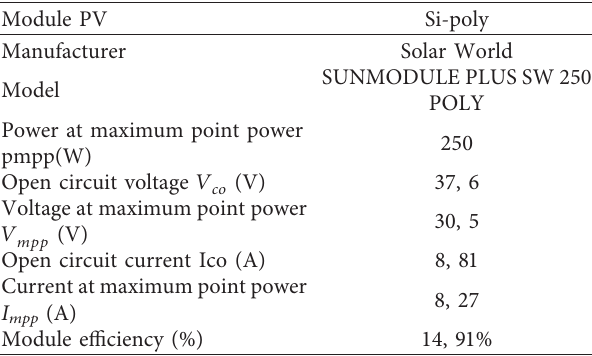
Figure 3: ENSET School PV system. (a) The panels’ orientation. (b) The panels’ structure. Table 2: The electrical characteristics of PV modules of the ENSET PV system.